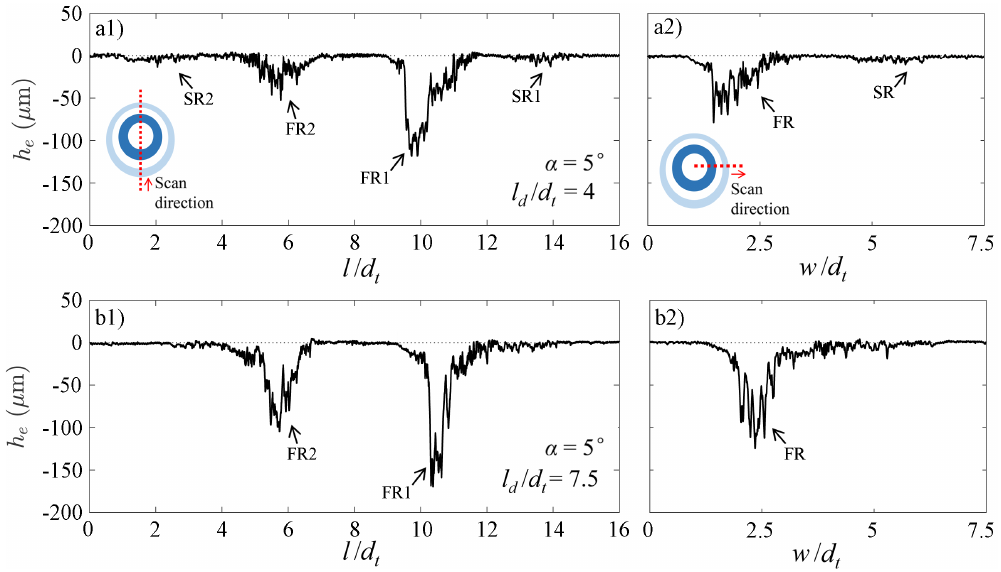
Figure 7. Profiles of the erosion at α = 5 ◦ . ( a1 ) longitudinal section at l d / d t = 4; ( a2 ) transverse section at l d / d t = 4; ( b1 ) longitudinal section at l d / d t = 7.5; ( b2 ) transverse section at l d / d t =